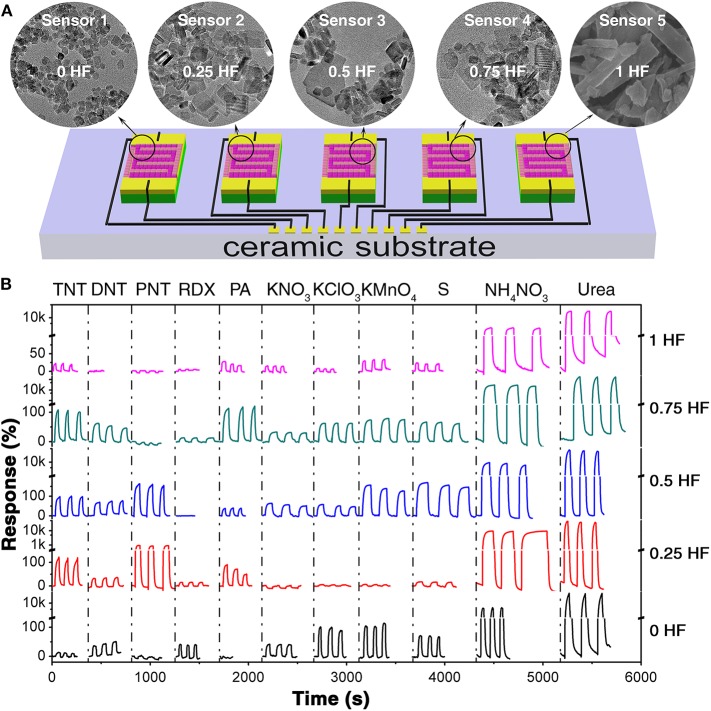
(A) The schematic diagram of the gas sensor array based on TiO2 nanosheets. (B) The corresponding response curves toward 11 explosive vapors (TNT, DNT, PNT, RDX, PA, KNO3, KClO3, KMnO4, S, NH4NO3, and urea).